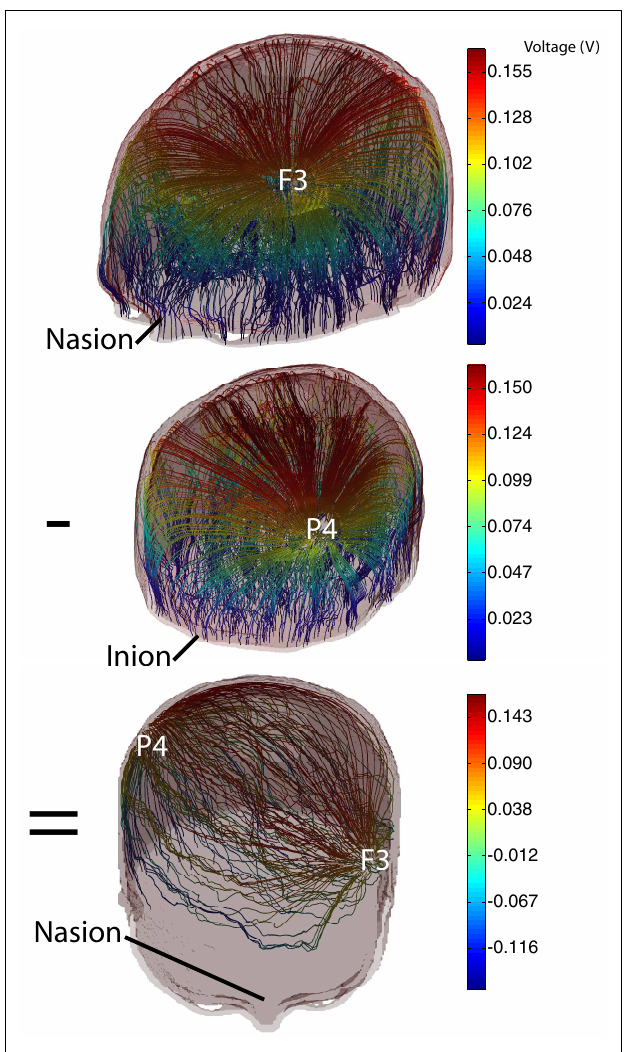
FIGURE 2 | Illustration of addition of 2 base voltage distributions with opposite weights to form a generic 2-electrode tDCS pattern. (Top) Current streamlines formed between the electrode at F3 and model base; (center) current streamlines formed between P4 and model base; (bottom) current streamlines resulting from subtraction of P4 data from F3 data. Streamline colors are indexed to voltage